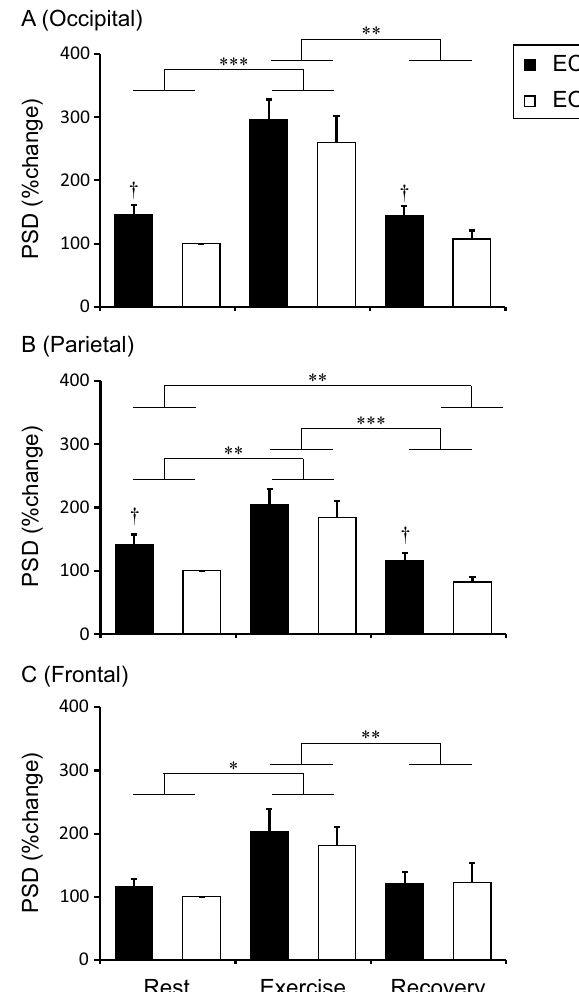
Figure 2. Beta power spectrum densities in occipital ( A ), parietal ( B ), and frontal ( C ) site at the rest, exercise, and recovery periods. The values indicate the percentage change from Rest + EO and are shown as the mean ± standard error (N = 15). * p < 0.05, ** p < 0.01, *** p < 0.001. † p < 0.05 vs EO. PSD power spectrum